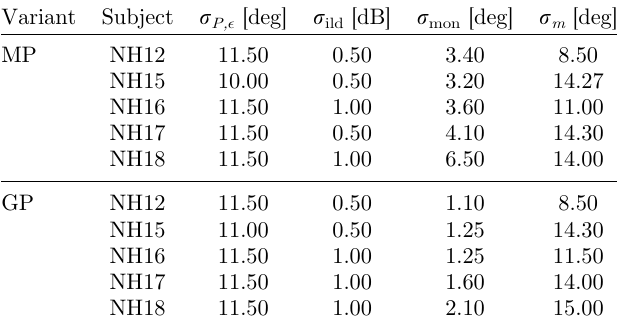
Table 1. Fitted parameters for both model variants where the monaural spectral features were either magnitude pro fi les (MPs) or gradient pro fi les (GPs). Subjects ’ performance from [23].